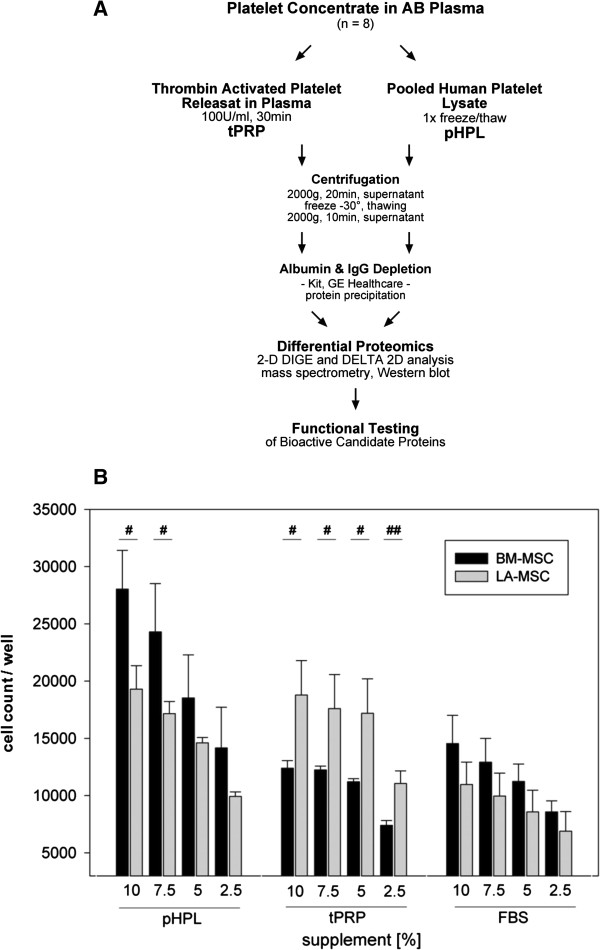
Experimental strategy and effect of human supplements on MSC proliferation. (A) Experimental strategy and (B) proliferation of MSC affected by the use of different supplements. Cell numbers were determined by the CellTiter-Glo assay on day 3 after seeding 3000 cells/well. Absolute MSC cell counts are shown related to decreasing supplement concentrations of pHPL, tPRP or FBS. Three independent experiments with three replicates were performed (#: p < 0.05; ##: p < 0.01).